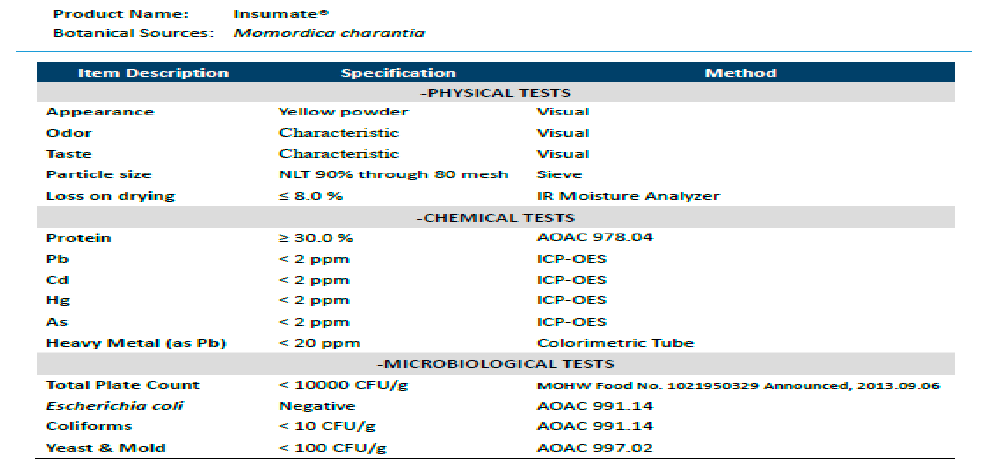
Figure A1. The specifications of Bitter melon peptide. Pb, Plumbum; Cd, Cadmium; Hg, Mercury; As, Arsenic.